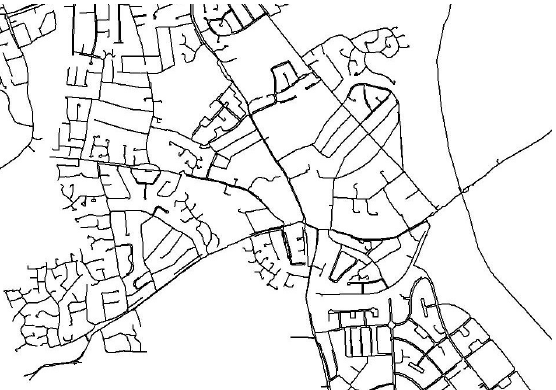
Figure 1. An example water supply pipe map for a region in the UK. The range of pipe layouts can be seen: straight pipes, curved pipes, and pipes with sharp corners. The scale of the map is 2 km from the bottom to the